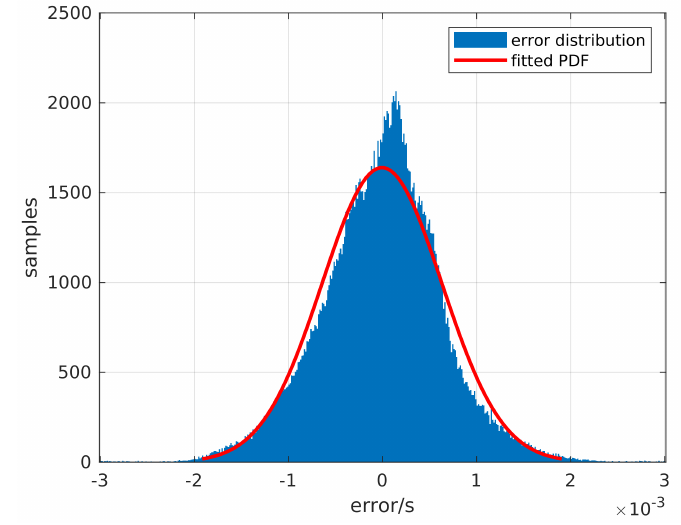
Figure 11. Fitting the TDoA error with a Gaussian